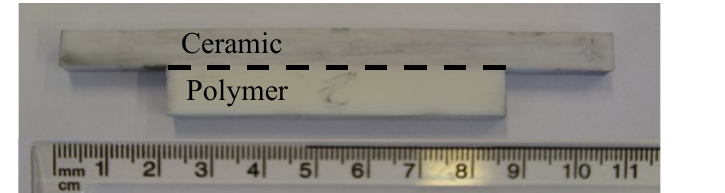
Fig. 1. Typical composite 3 point bend specimen. The central load was applied on the ceramic side and the specimen was painted with a fine speckle pattern for digital image correlation (DIC) analysis.